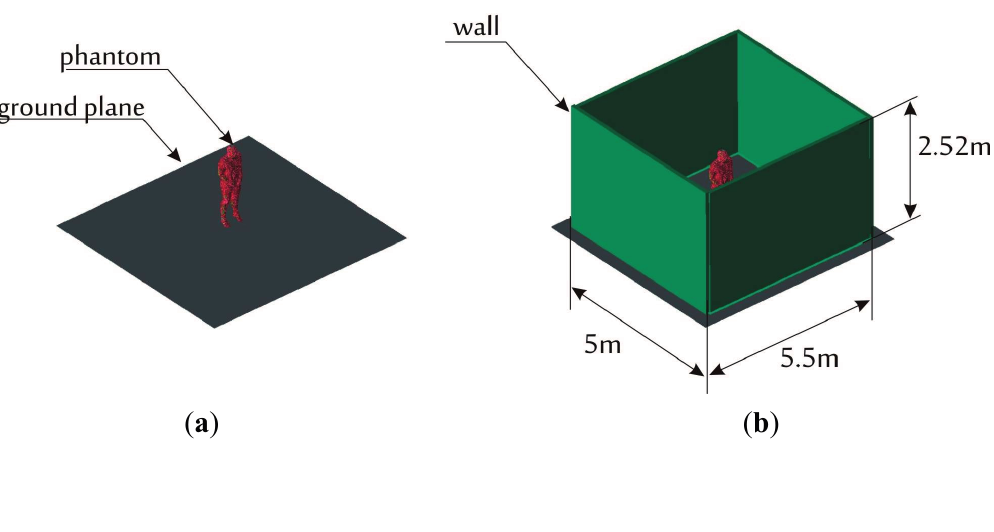
Figure 2. Human body model in two environments: ( a ) with a ground plane only; ( b ) with a ground plane and four walls. The third case with a ceiling is not shown but was also